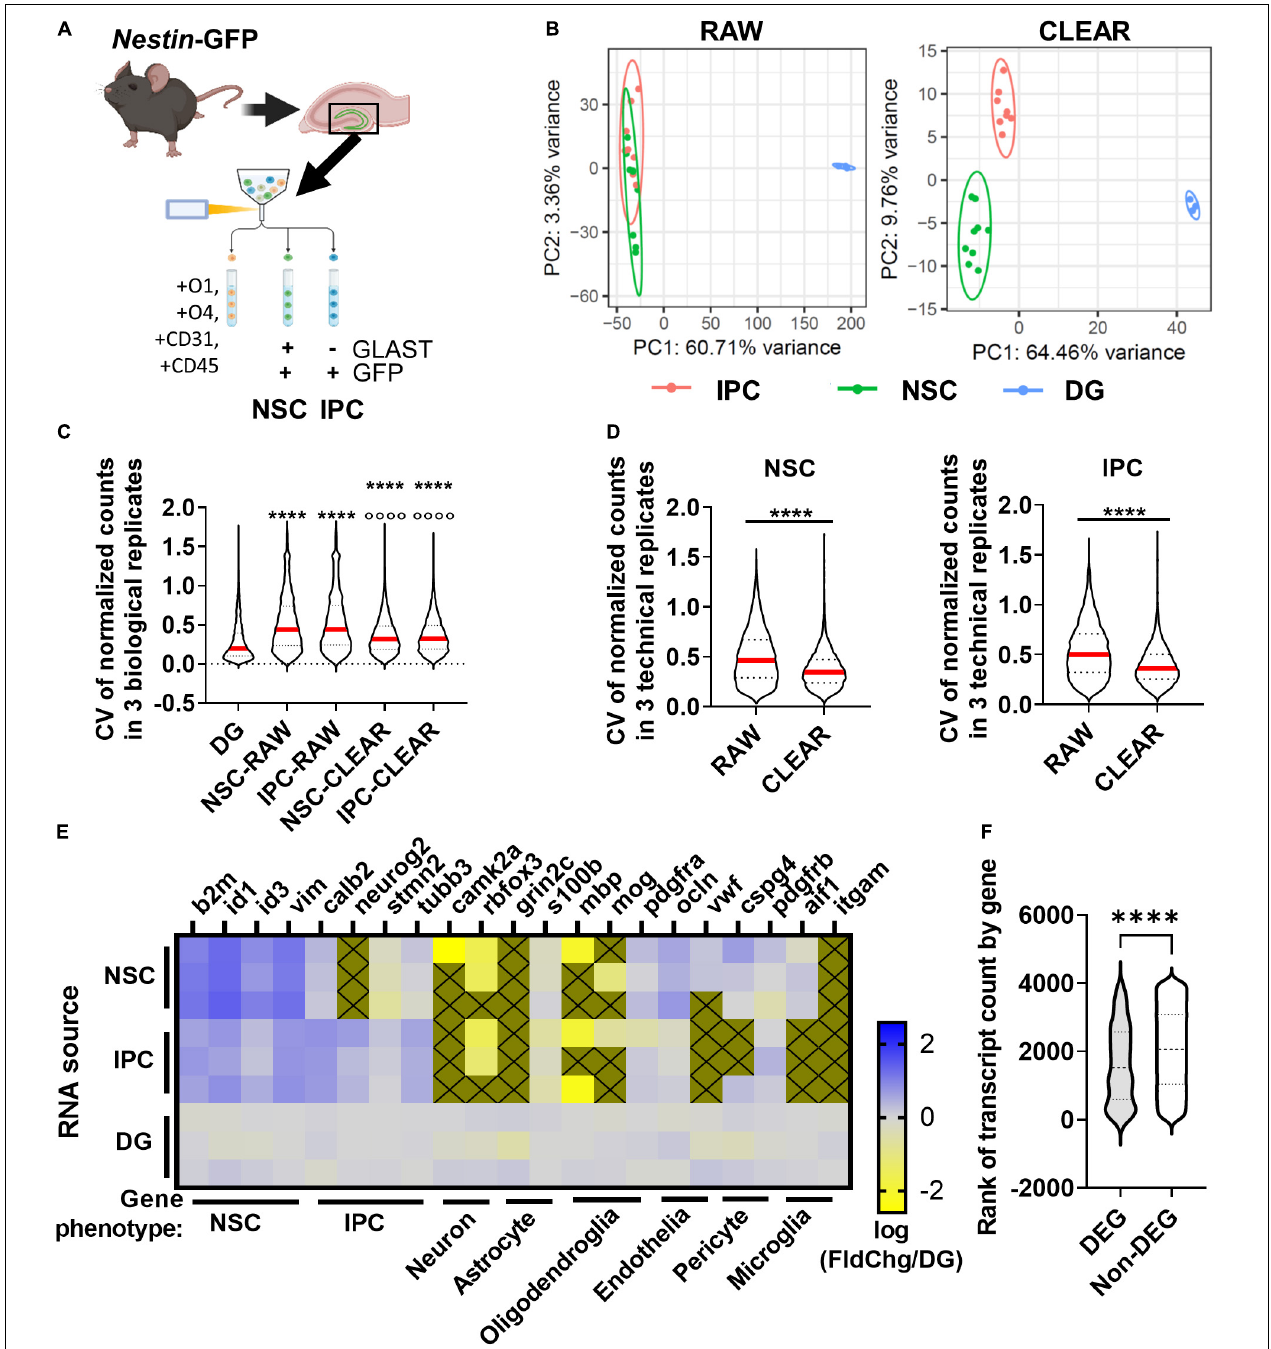
FIGURE 5 | DEG identification in vivo . (A) Workflow for DEG identification from hippocampal NSCs and IPCs of individual adult mice. DGs from Nestin-GFP+ mice were isolated and homogenized into single cell suspensions enabling FACS isolation of NSCs and IPCs for lcRNAseq. (B) PCA of transcriptome using unfiltered RAW and CLEAR filtered data. CLEAR filtering improves separation and variance between NSC and IPC samples. (C) CV for NSC and IPC biological replicates before and after CLEAR filtering. Dunn’s multiples comparisons ∗∗∗∗ p < 0.0001 vs. DG p < 0.0001 vs. raw RGL and raw IPC. (D) CV for NSC and IPC technical replicates (3/mouse) before and after CLEAR filtering. Unpaired t -test ∗∗∗∗ p < 0.0001. (E) Heatmap shows expression of phenotypic genes in each of three biological replicates for NSCs, IPCs, and whole DG which was sequenced from three separate Wt mice in parallel. High expression of NSC phenotypic markers in NSCs and high expression of IPC phenotypic markers in IPCs confirmed cell type identities. Low expression of neuronal, astrocytic, oligodendroglial, endothelial, pericyte, and microglial phenotypic genes confirmed exclusion of other major DG cell types. Gold boxes with an X were not detected. (F) Comparison of ranked transcript counts for DEGs and Non-DEGs identified between NSCs and IPCs shows a significant but moderate shift in DEGs toward higher ranked genes. Mann–Whitney test ∗∗∗∗ p < 0.0001.